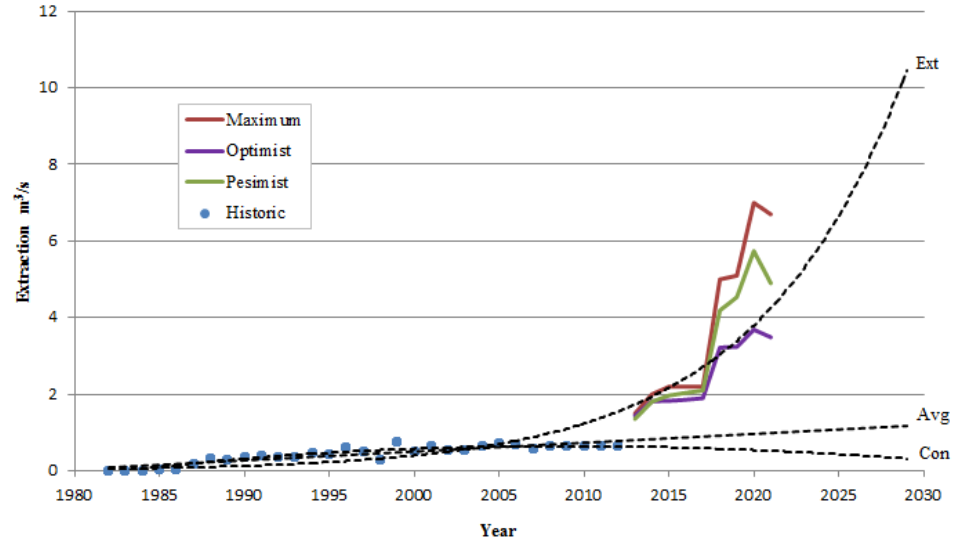
Figure 6. Mining growth projections with historic data and industry estimates.